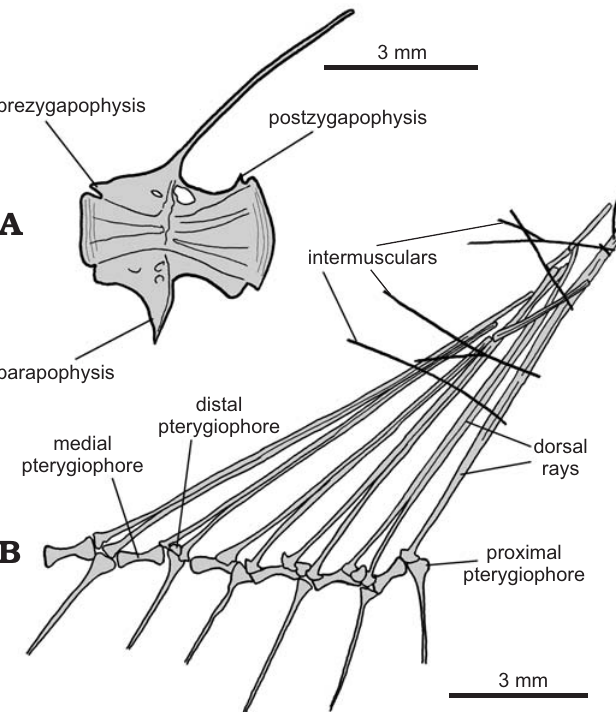
Fig. 5. Alepisauroid fish Polymerichthys sp. from Sakhalin Island, Holmsk Formation, late Oligocene (A) and Kurasi Formation, Middle–Late Miocene (B). A . ZIN 310p, abdominal centrum. B . ZIN 314p, fragment of the dorsal